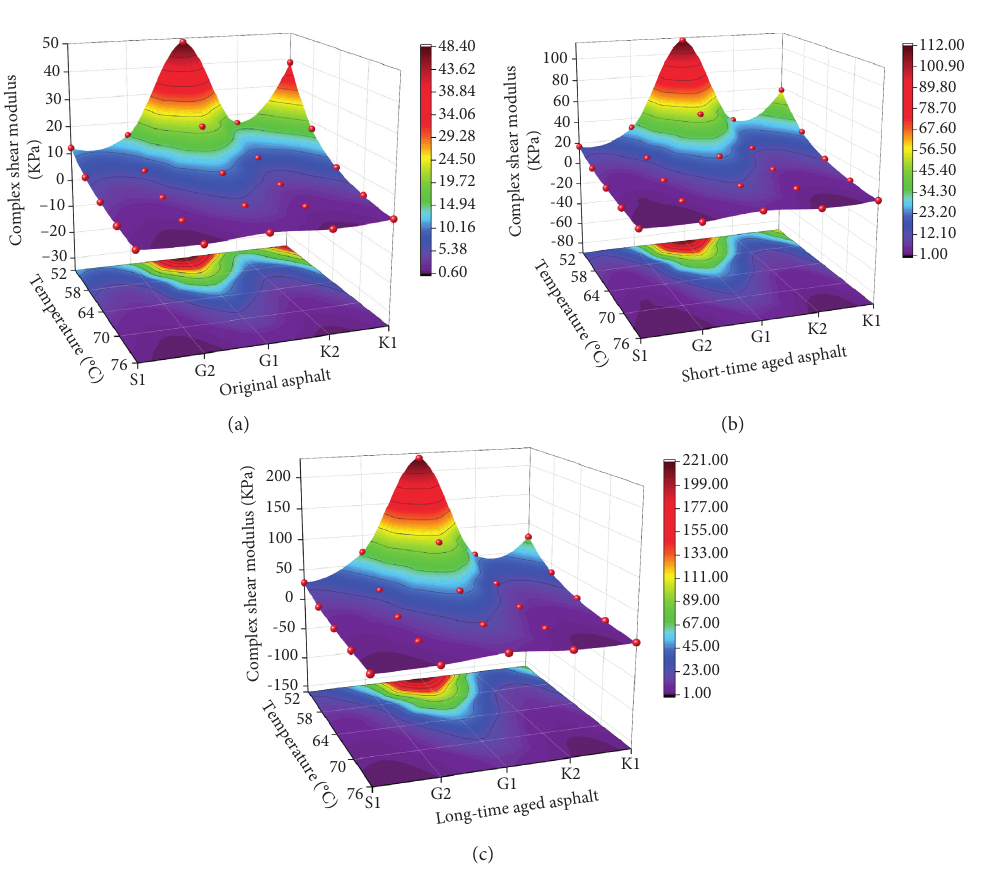
Figure 2: G ∗ at different aging states. (a) Original asphalt. (b) Short-time aged asphalt. (c) Long-time aged